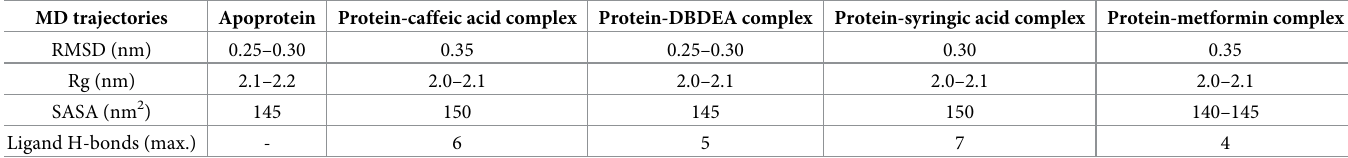
Table 4. MD trajectory values of JME phytocompounds and metformin complexed with human MAPK3 protein. MD